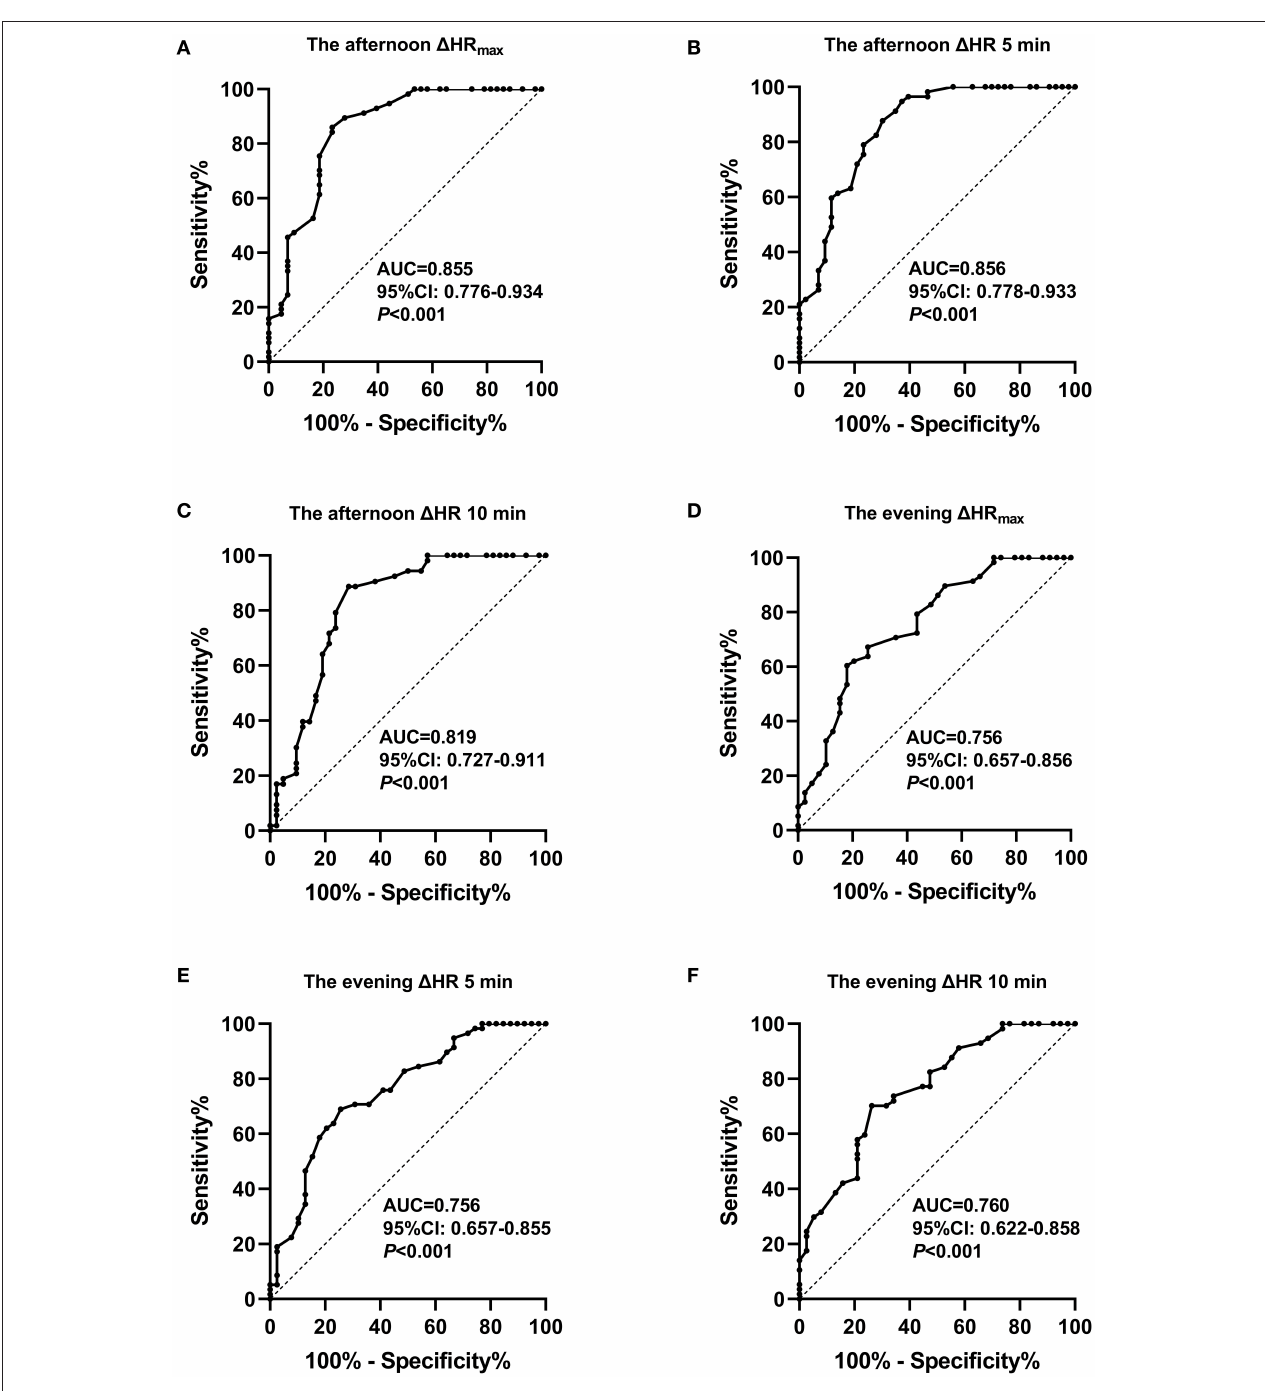
FIGURE 3 | Receiver operating characteristic curve analysis of orthostatic heart rate parameters in the afternoon and evening standing tests to predict the POTS diagnosis. (A) The maximum heart rate increment ( 1 HR max ) in the afternoon standing test. (B) 1 HR at 5min in the afternoon standing test. (C) 1 HR at 10min in